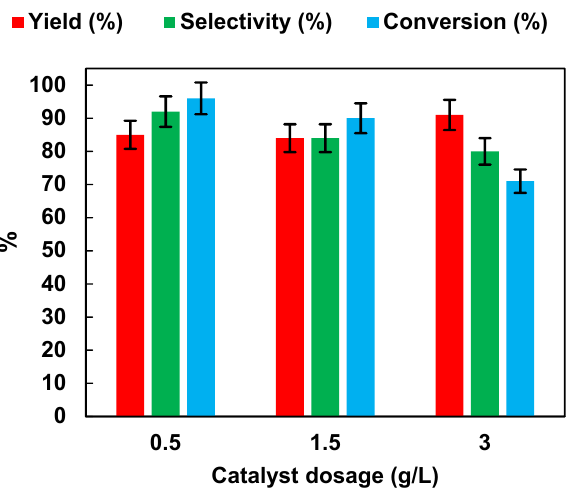
Figure 7. Effects of TiO 2 (P25) dosage on AN yield, AN selectivity, and NB conversion. UV irradiation time t is 45 min. Error bar ±5%.